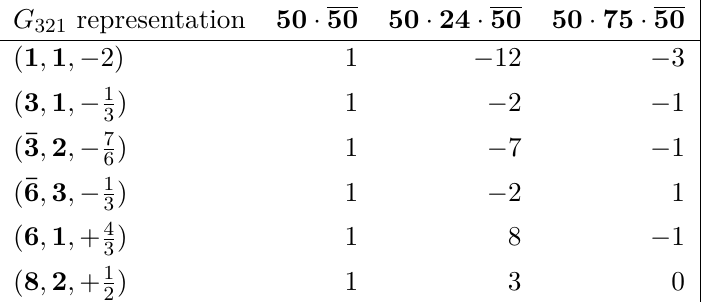
controls how high the effective triplet 50